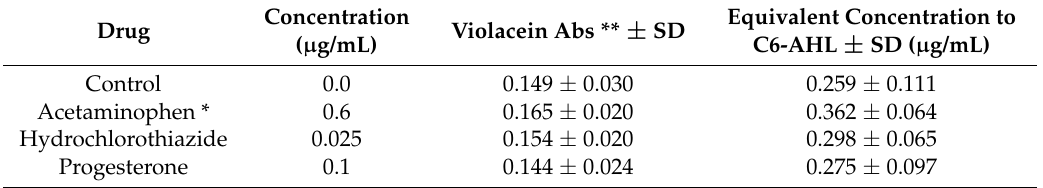
Table 4. Concentration of C6-AHL in K. pneumoniae ATCC 13884 cultures under the effect of biofilm-inducing drugs. Final incubation time 2 h at 37 ◦ C.